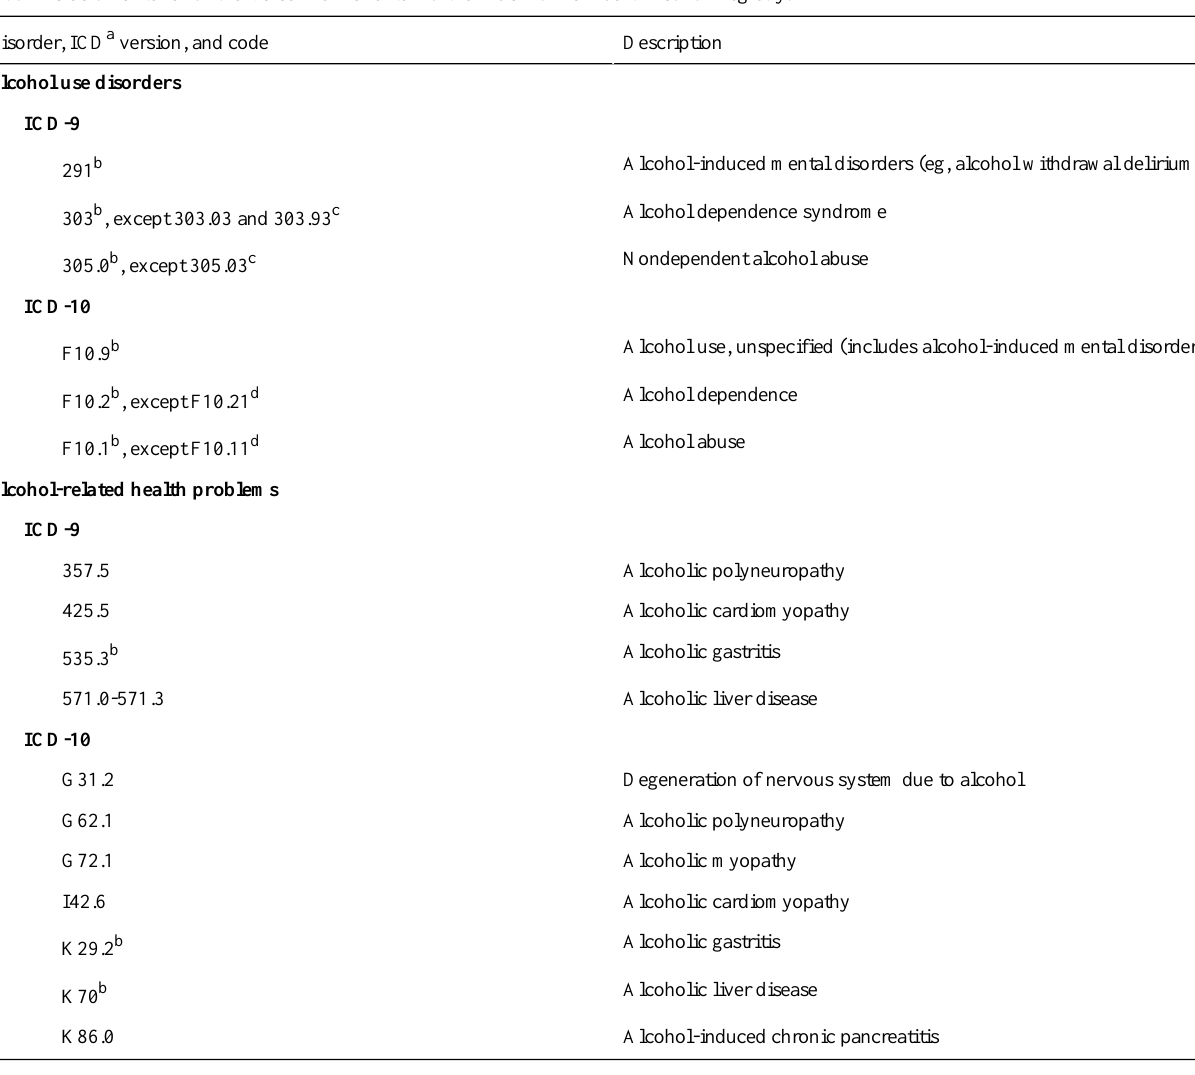
Table 1. International Classification of Diseases (ICD) codes for identification of active alcohol use disorders and alcohol-related health problems as part of inclusion criteria for the Kaiser Permanente Northern California Adult Alcohol